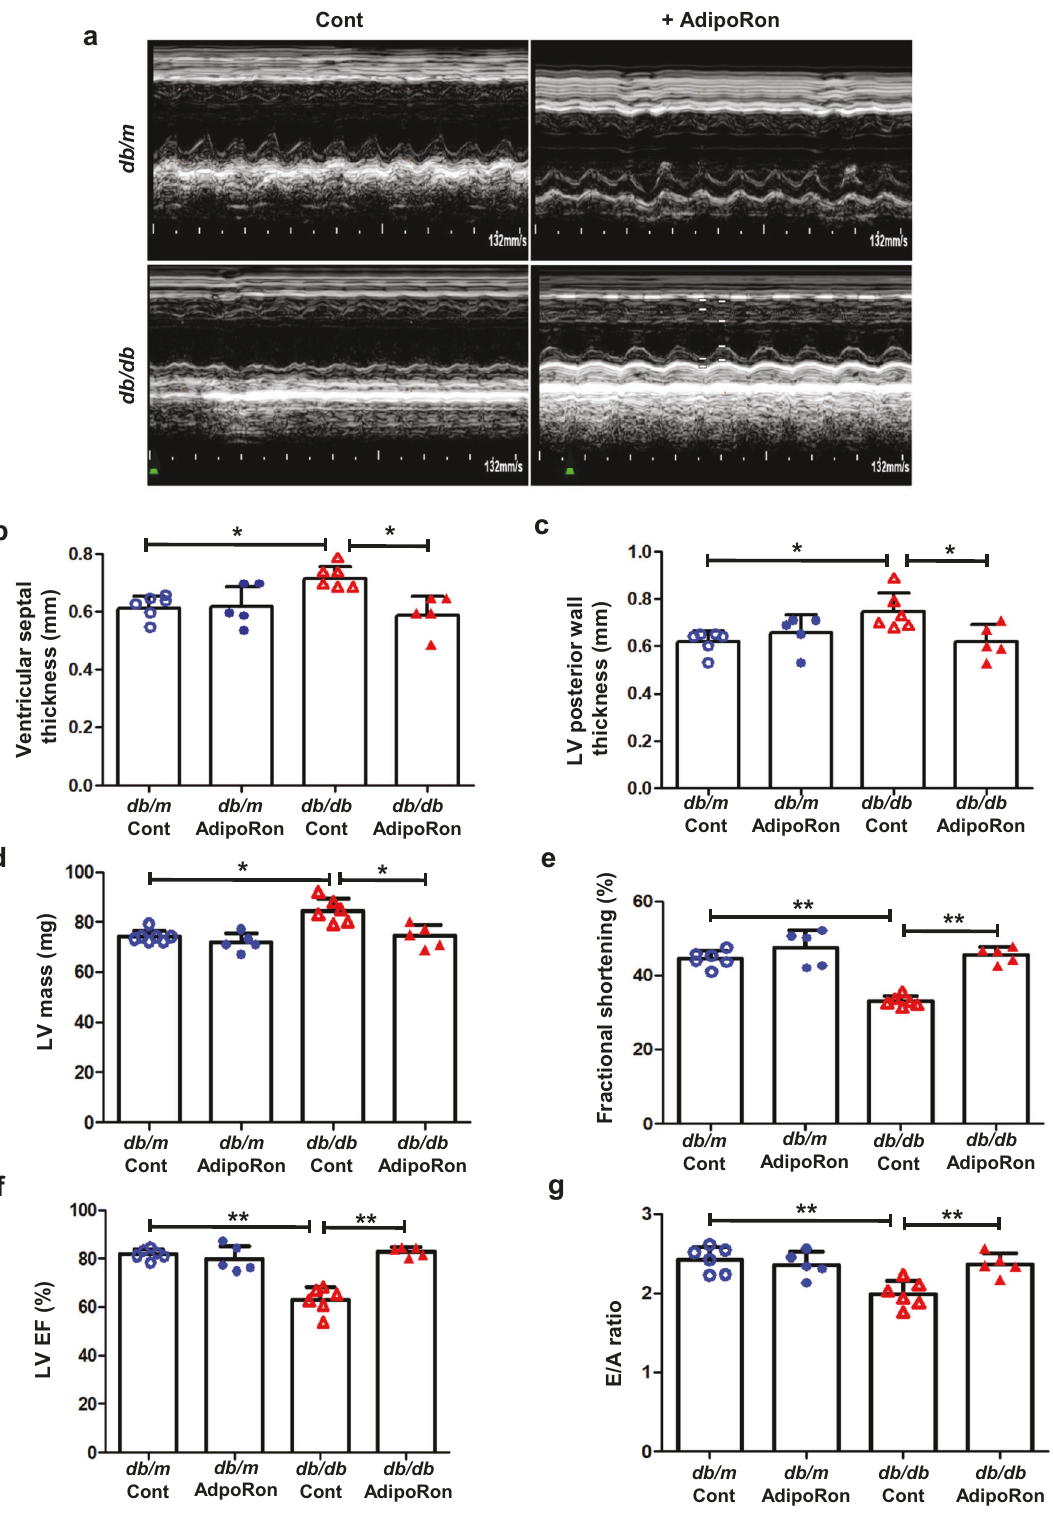
Fig. 1 Changes in echocardiographic parameters of diabetic and non-diabetic mice with or without AdipoRon treatment. a Representative images of echocardiogram. b-g Quantitative analyses of echocardiographic fi ndings according to groups. * P < 0.05, and ** P < 0.01 compared with other